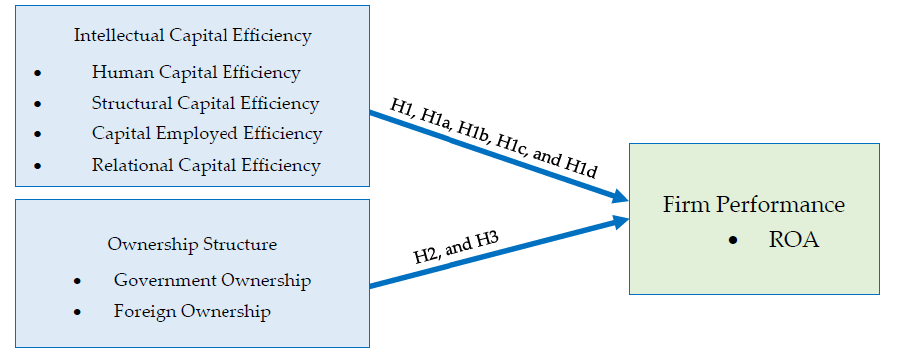
Figure 1. Theoretical framework.